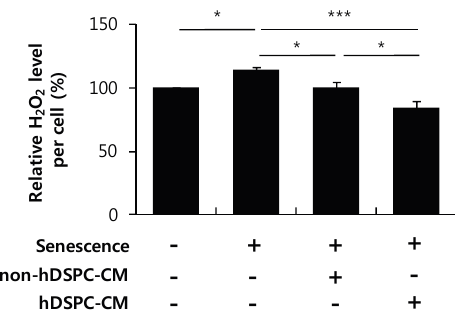
Figure 4. hDSPC-CM inhibited H 2 O 2 generation in senescent fibroblasts. Basal H 2 O 2 levels in senescent fibroblasts were measured with Amplex Red fluorescent dye at 24 h after treatment with the indicated CMs, as described in the Experimental Section. Graphs depict means ± S.E.M of three independent experiments. * p < 0.05, *** p < 0.001. Data were statistically compared with one-way analysis of variance.